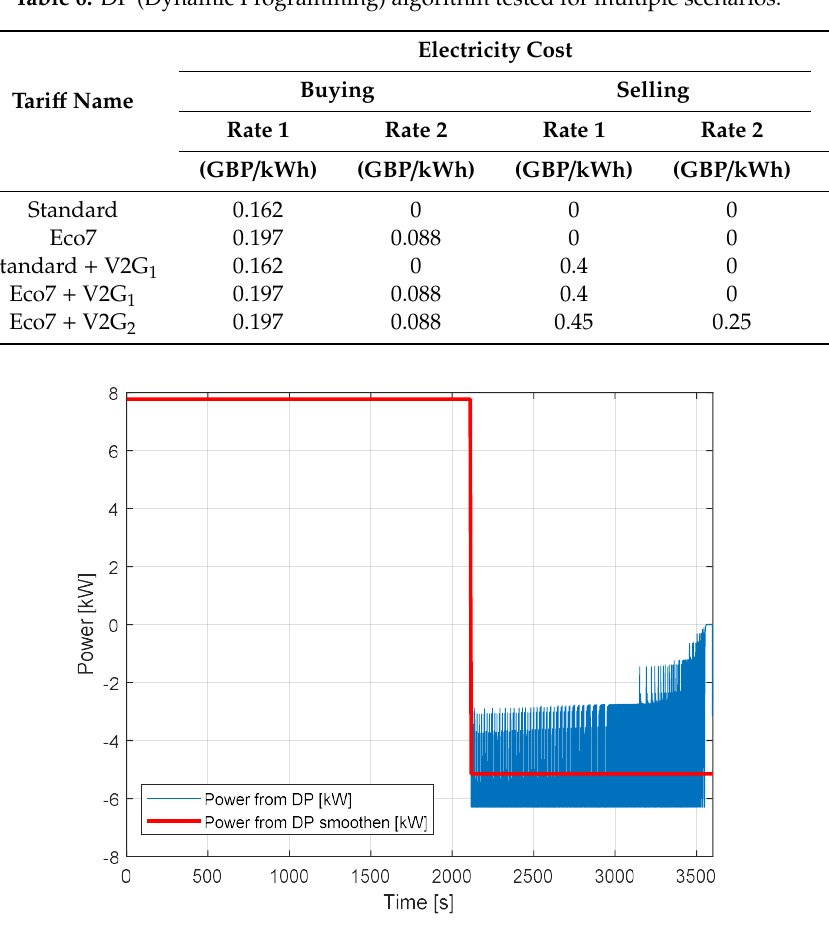
Figure 14. Optimised charging profile for scenario 5.